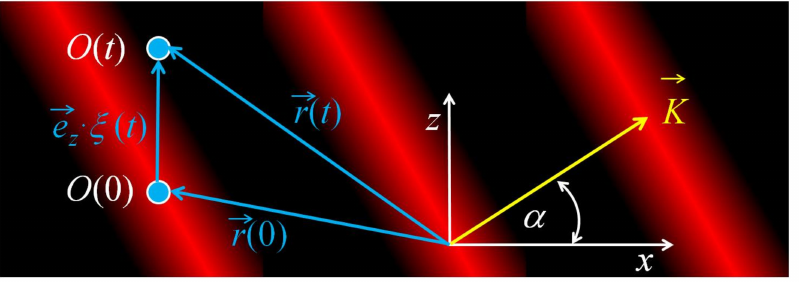
→ (cid:16) → (cid:17) K · e z · ξ ( t ) of the point O during plate